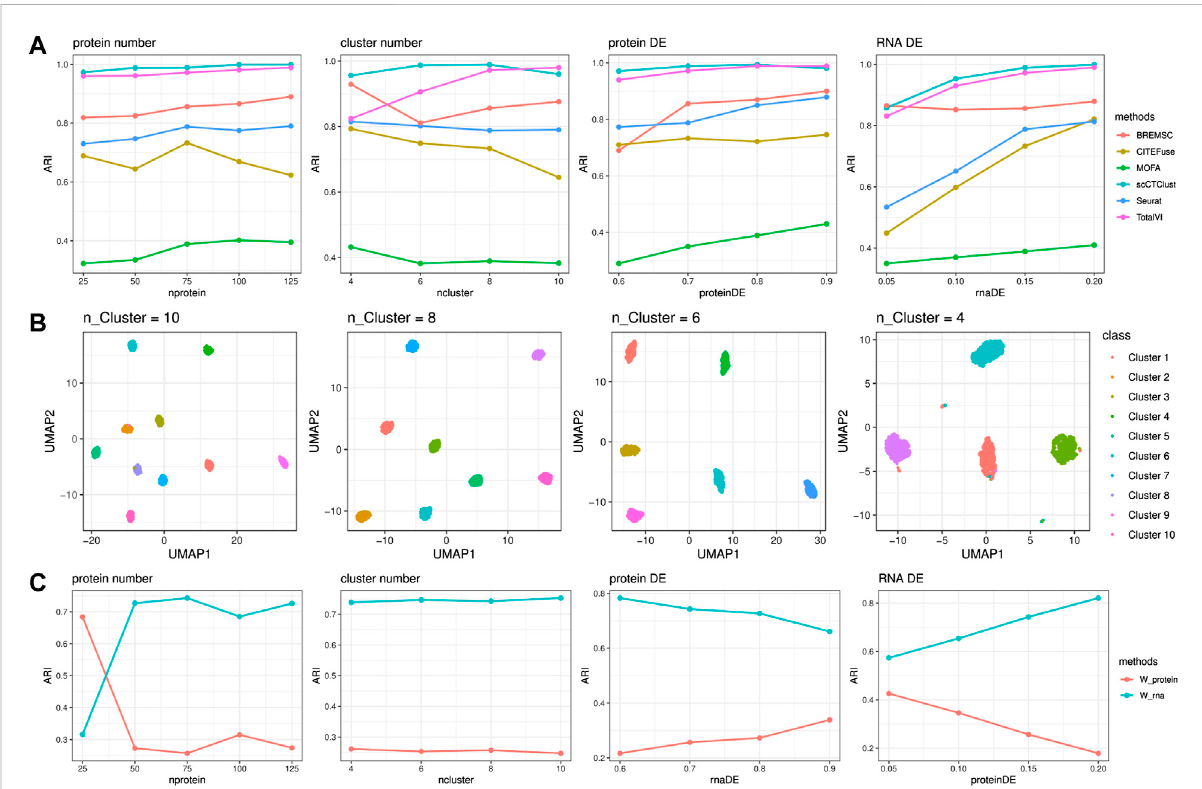
FIGURE 2 SimulationExperiments. (A) PerformanceofscCTClustandcompetingmethodsbyARIoversimulatedCITE-seqdatasets. (B) Two-dimensional visualization of latent features extracted by scCTClust using the UMAP dimension reduction method. Only cluster numbers varied in according experiments. (C) Behavior of fusion weights during the simulation